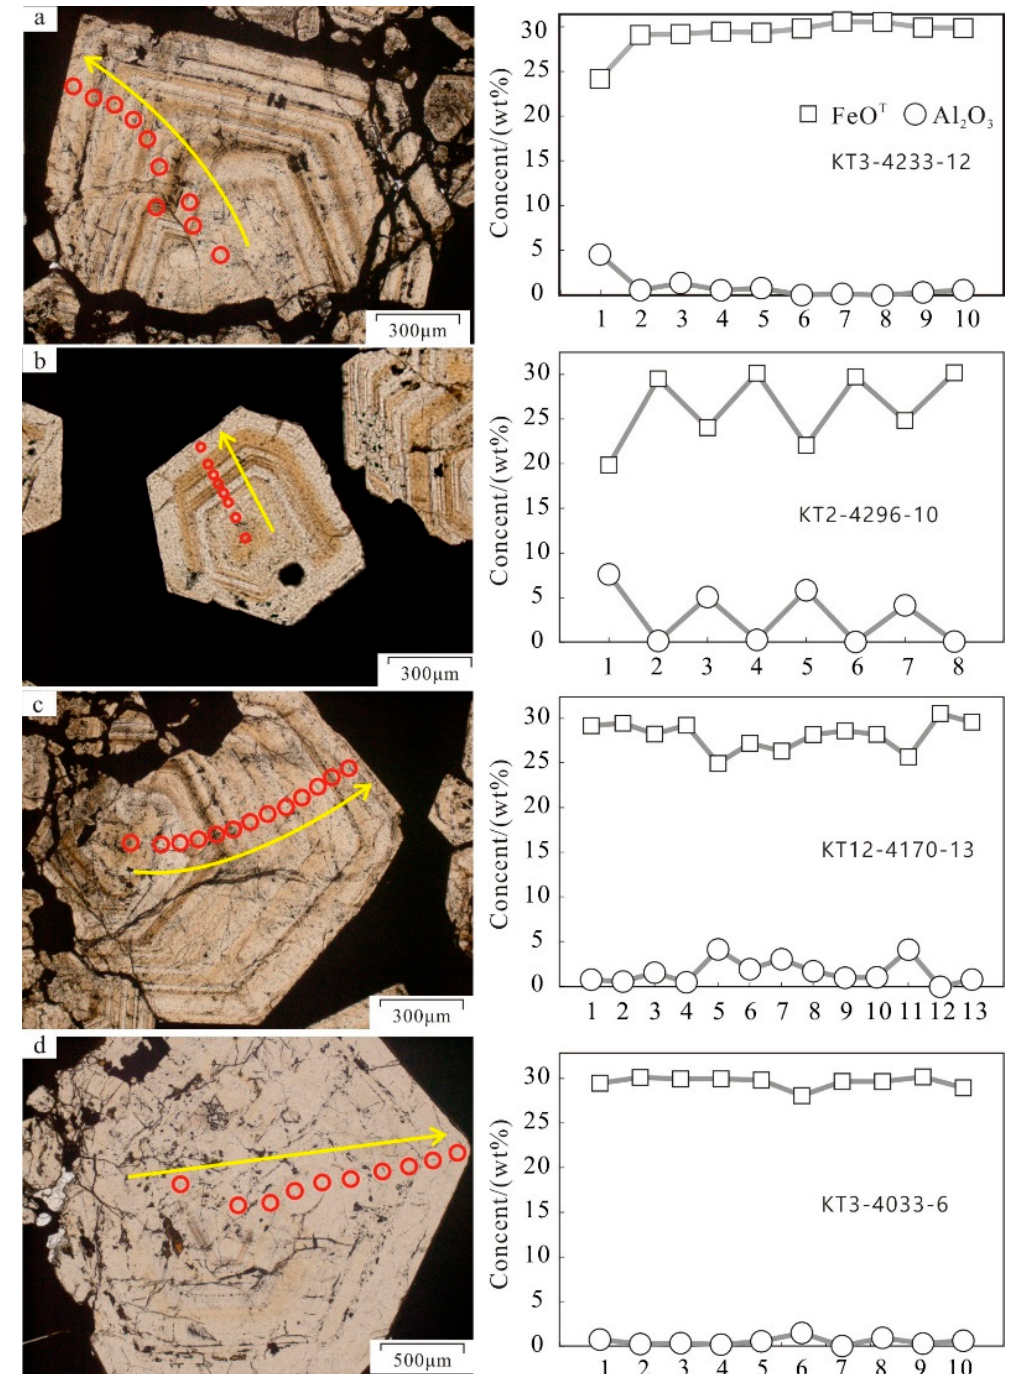
Figure 5. Variation of FeO T and Al 2 O 3 content from core to margin in the garnet grains from the layered skarn ores.